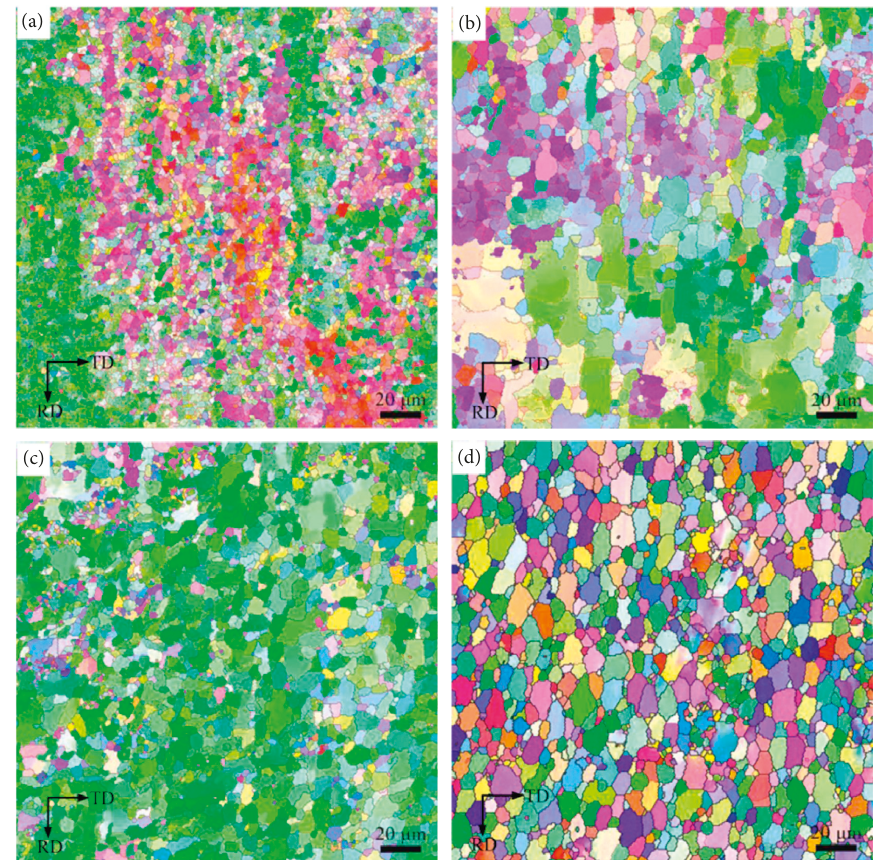
Figure 11: EBSD analyses of the Al-Zn-Mg-0.25Sc-0.10Zr alloy deformed at 500 ° C and 1 × 10 − 2 · s − 1 after interrupting the tensile test at different strains: (a) ε � 0; (b) ε � 0.69; (c) ε � 1.10; (d) ε � 2.40